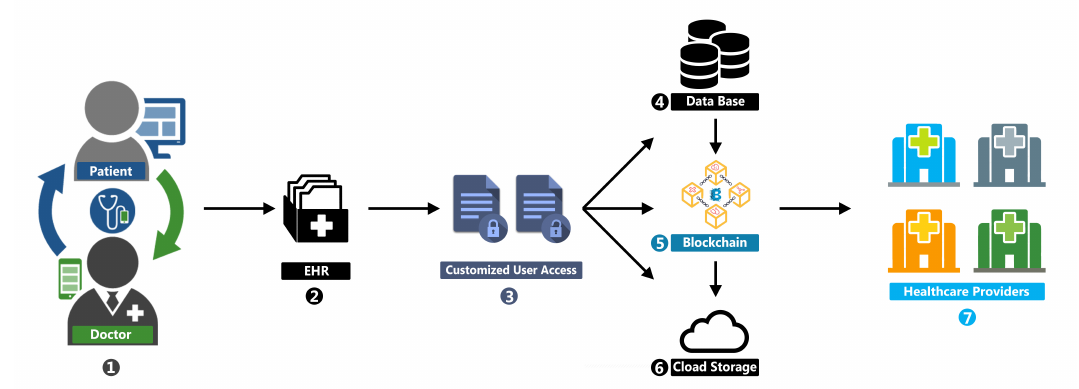
Figure 3. Healthcare data management in